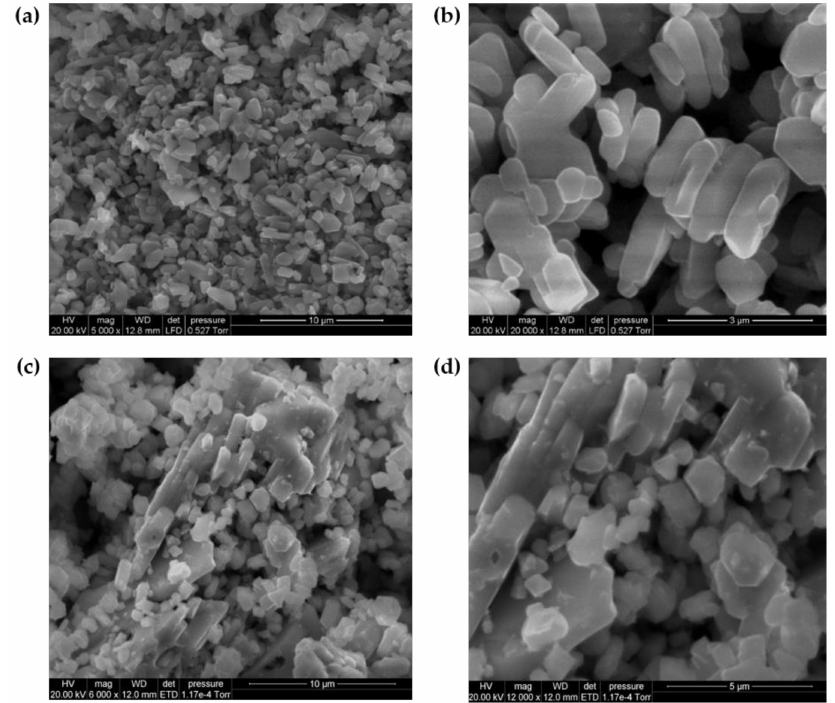
Figure 1. Environmental scanning electron microscopy (ESEM) pictures were collected on the anisotropic SrFe 12 O 19 ferrite samples ( a , b ) and on the isotropic ferrite ones ( c , d ) at different magnifications. In both the FTIR spectra of is-SrFe 12 O 19 and anis-SrFe 12 O 19 (Figure 2), the character- istic peaks at around 620 and 540 cm − 1 (the asterisks in Figure 2) together with those at around 600 and 440 cm − 1 (the circles in Figure 2, assigned to the Fe-O bending of Fe-O 4 , tetrahedral, and Fe-O stretching of Fe-O 6 , octahedral, respectively) are present. The slight difference in the relative intensities of the peaks can be related to the different shapes and compositions [44]. There is no evidence of adsorbed water in both cases.